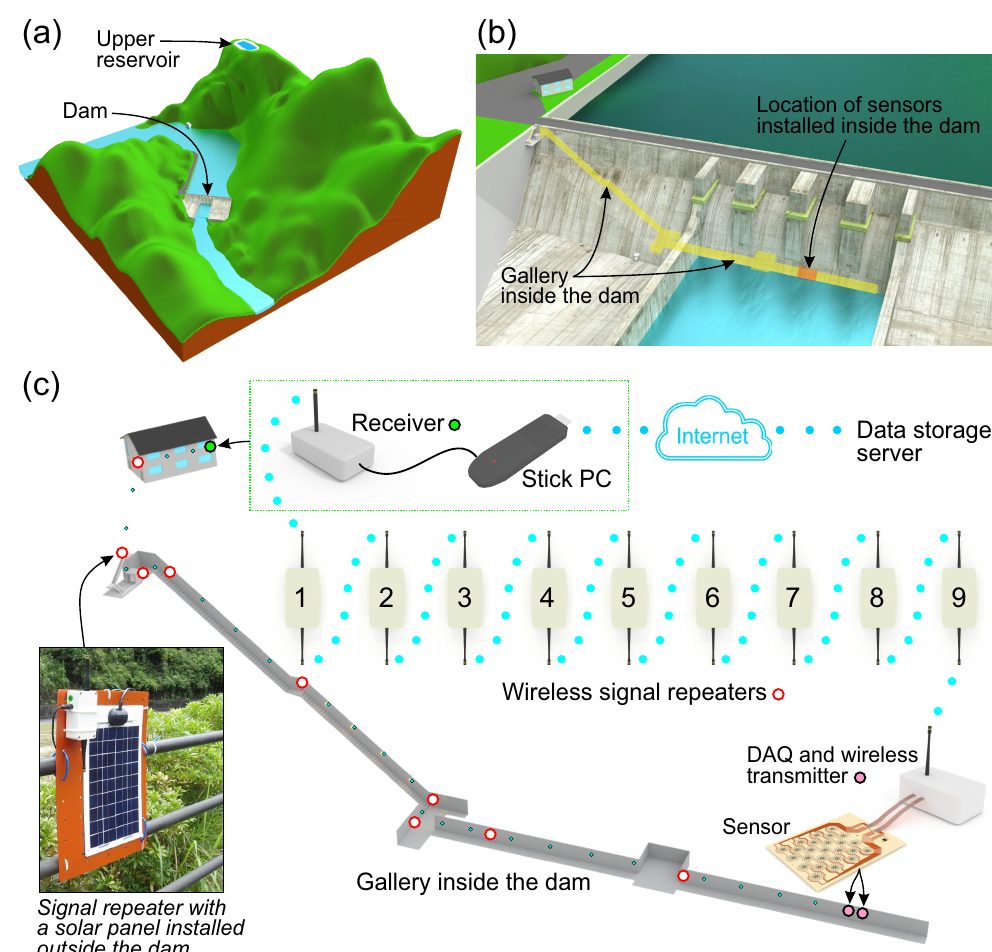
Figure 2. ( a ) Illustration of a pumped storage power station that consists of the dam and upper reservoir. Its operation regulates water level changes on the dam. ( b ) Location of sensors installed on the gallery wall inside the dam. ( c ) Sensing system that incorporates wireless signal repeaters installed along the